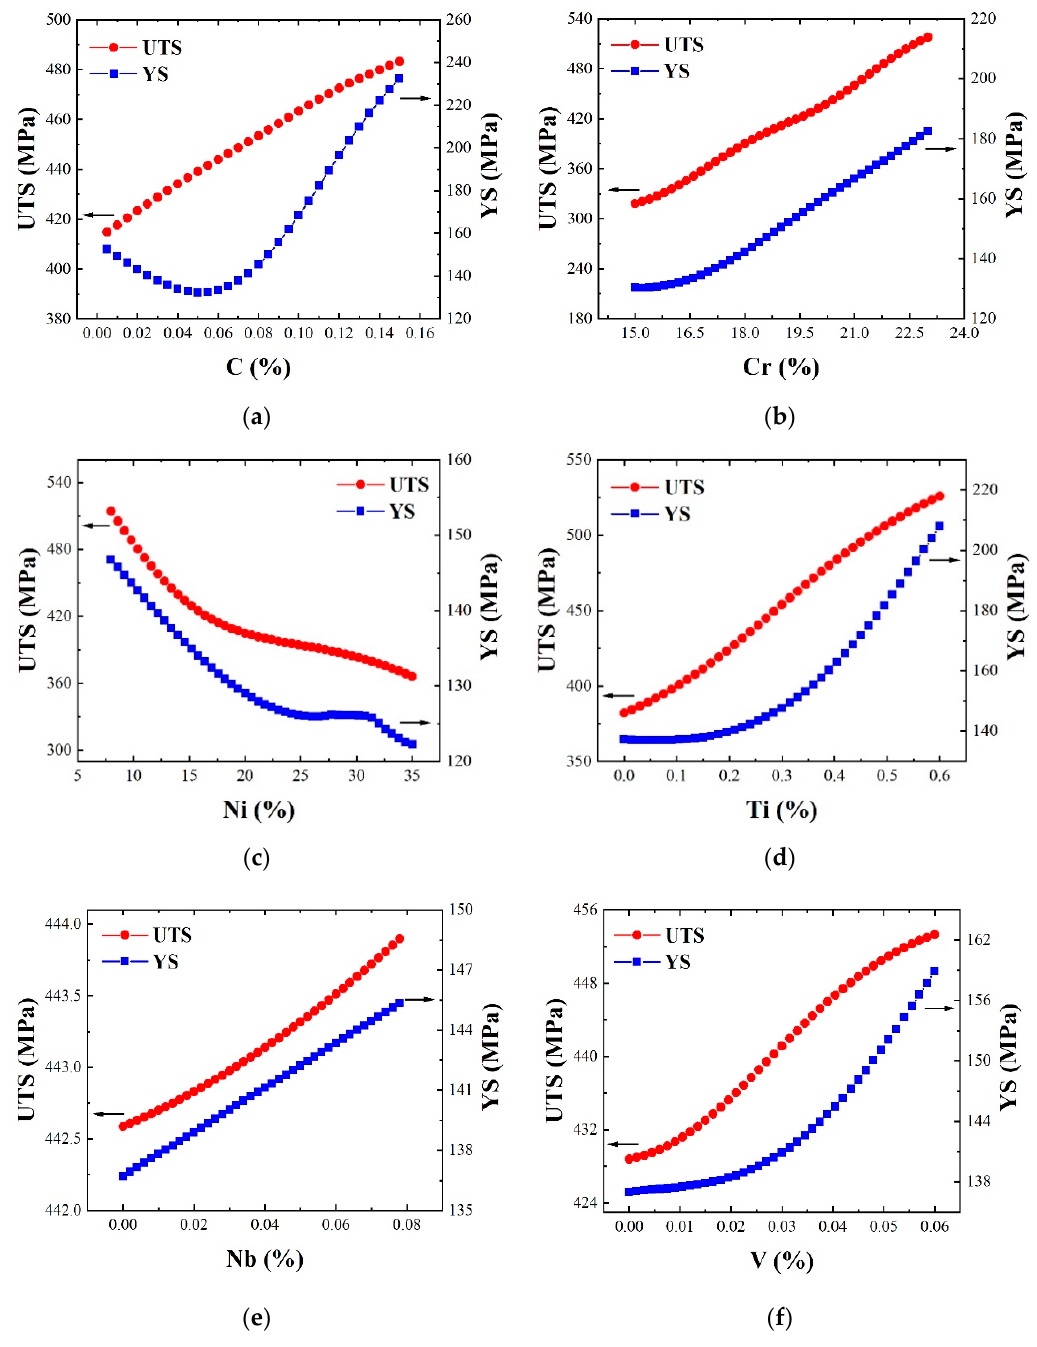
Figure 7. The predicted influence trends of ( a ) carbon, ( b ) chromium, ( c ) nickel, ( d ) titanium, ( e ) niobium and ( f ) vanadium on YS and UTS. The red and blue dots represent the predicted values of UTS and YS respectively.